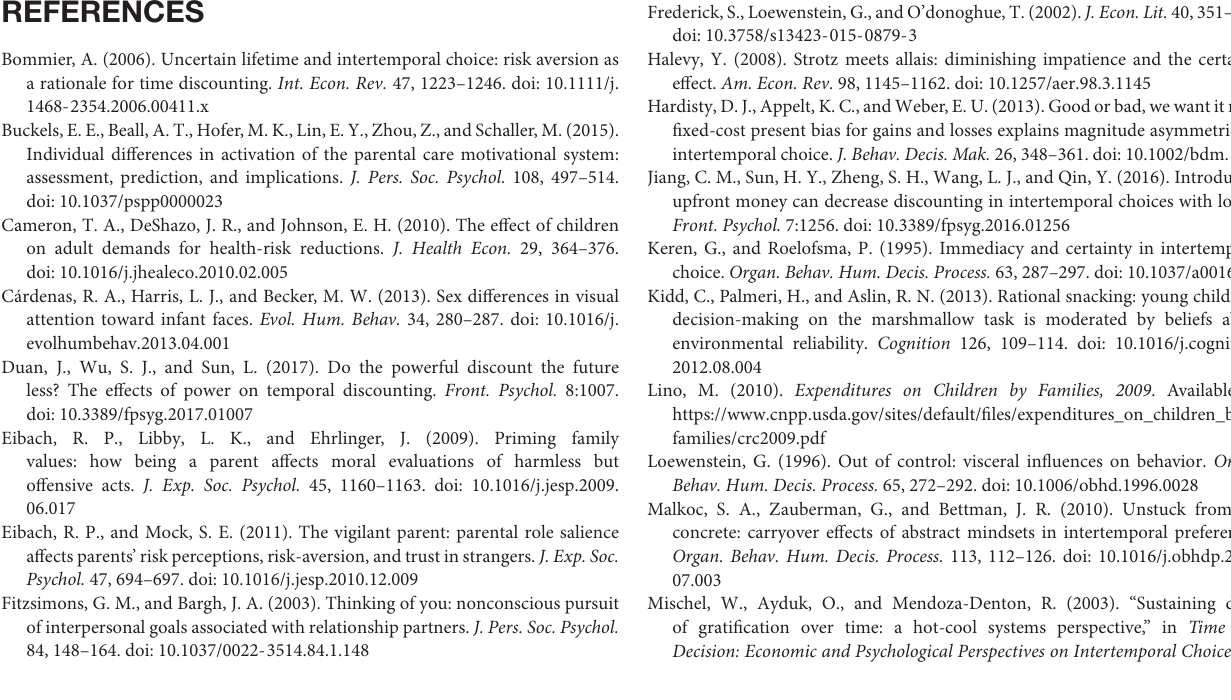
FIGURE S1 | (A) Initial setting of smaller-sooner option is $75. (B) If first choosing larger-later option, the smaller-sooner option becomes $112.5. (C) If first choosing smaller-sooner option, the smaller-sooner option becomes